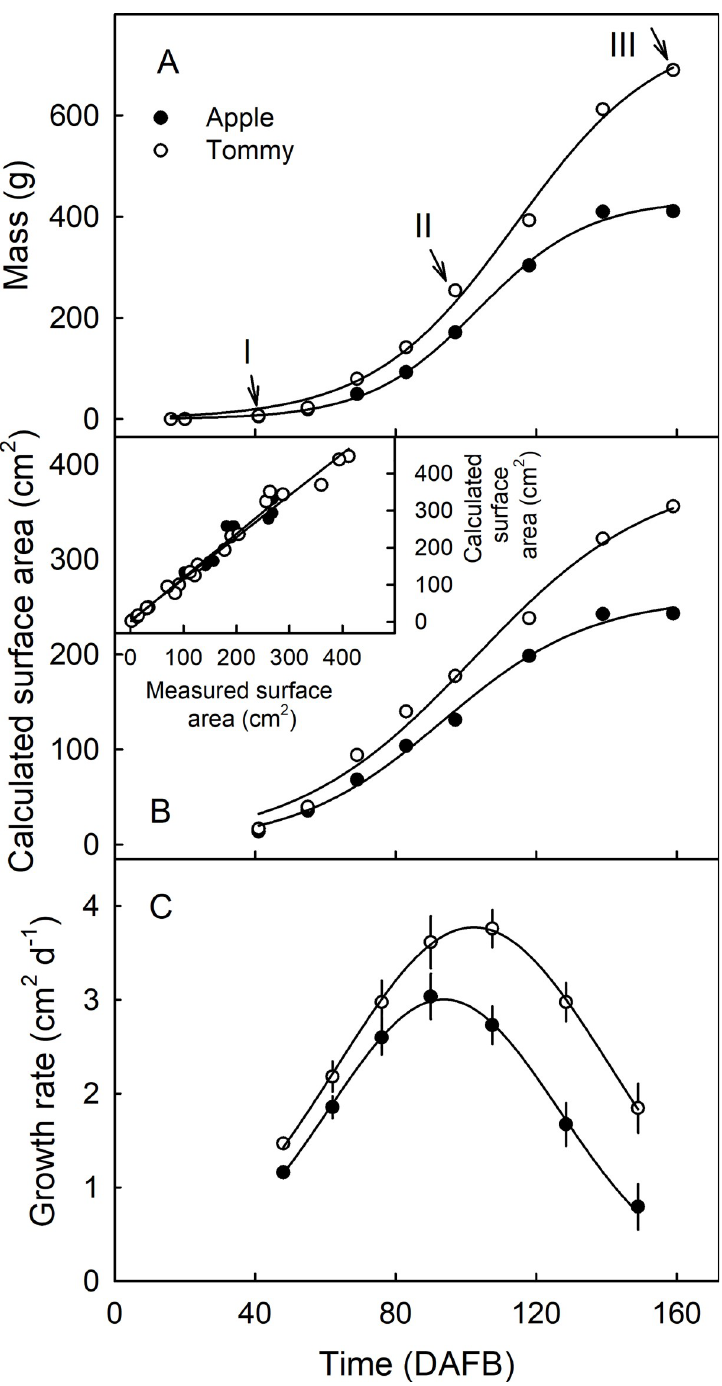
Fig 2. Time course of change in mass (A), calculated surface area (B) and growth rate (C) of ‘Apple’ and ‘Tommy Atkins’ mango. Inset in B: Plot of measured and calculated surface area of the fruit peel. The area was calculated assuming a spheroid shape. The x-axis scale is in days after full bloom (DAFB). Arrows indicate the sampling dates for histological examination. Data represent means ± SE. The number of individual fruit replicates was 10–20.